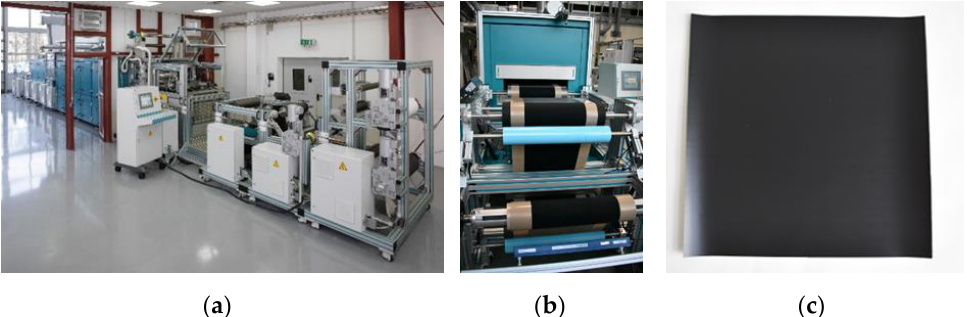
Figure 3. ( a ): Roll-to-roll coating system; ( b ): The coated substrate was dried and subsequently un- rolled; ( c ): The electrode was cut from the roll with dimensions of 32.5 × 32.5 cm 2 .